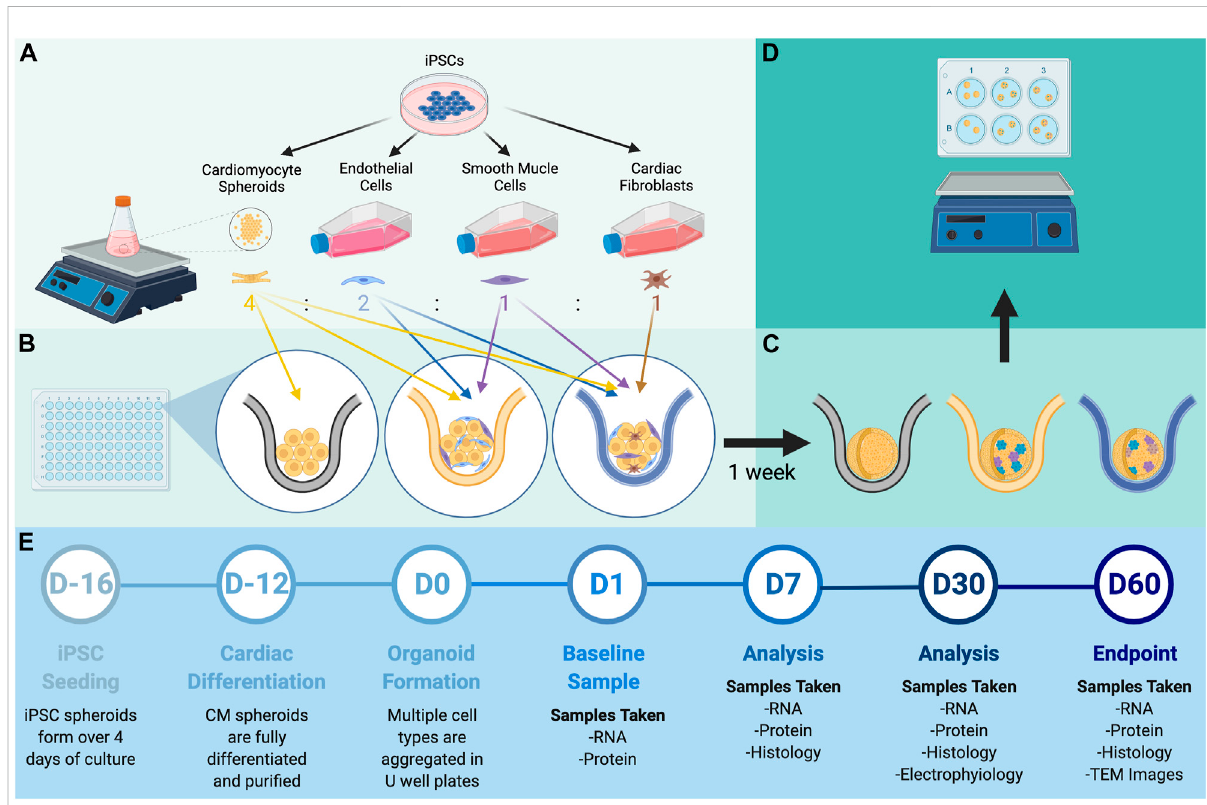
FIGURE 1 Experimentaldesign. (A) hiPSCsweredifferentiatedintoCMs,ECs,SMCs,andCFsviaestablishedmethods. (B) Spheroidscontainingallfourcell types (C4 spheroids) were produced by combining a 4:2:1:1 ratio of CMs, ECs, SMCs, and CFs in 96-well U plates and allowing the cells to fuse for 7 days; then, (C) the spheroids were transferred to 6-well plates and (D) cultured with shaking for to 60 days. (E) Procedures for spheroid manufacture and experimental analyses are displayed on a